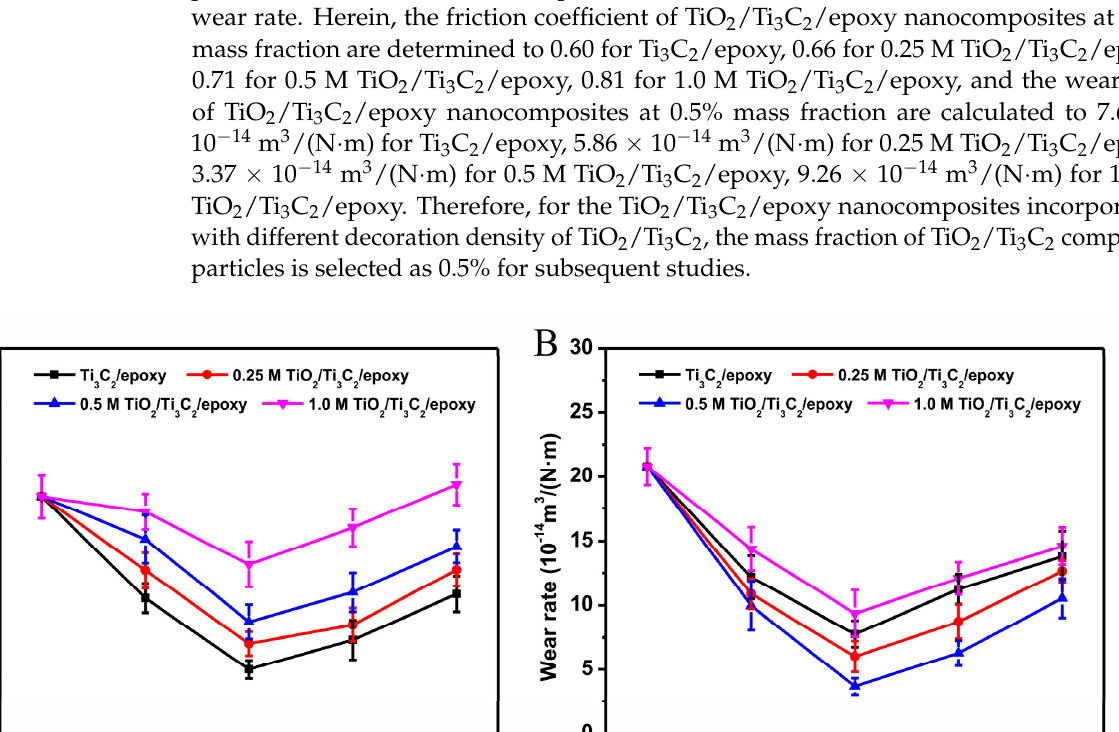
Figure 2. XRD patterns ( A , B ) and FTIR spectra ( C ) of Ti 3 AlC 2 , Ti 3 C 2 , and TiO 2 /Ti 3 C 2 .